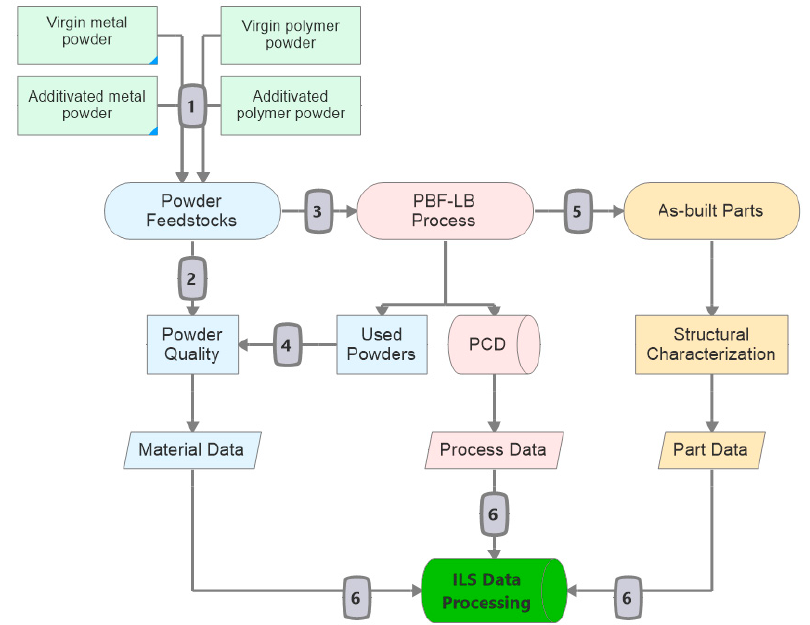
Figure 2. Workflow of inter-laboratory study (ILS) for powder bed fusion using laser beam (PBF-LB) of unmodified and NP-additivated metal and polymer powder feedstocks. The workflow consists of six steps: (1) nano-additivated powder production, (2) powder quality of unmodified and nanoparticle additivated powders, (3) PBF-LB of unmodified and additivated powders, (4) powder quality of used powders after the PBF-LB process, (5) testing as-built parts, (6) powder, process, part data generation, and ILS data processing. Topics in blue, pink, and orange represent the workflows to obtain the powder, process, and part data, respectively.